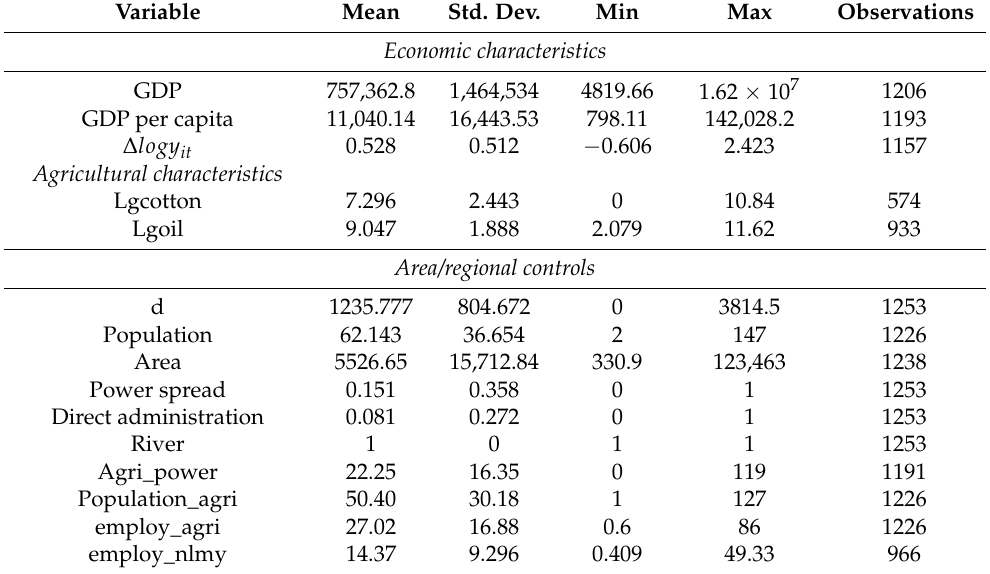
Table 2. Descriptive statistics of the main variables (treatment group).